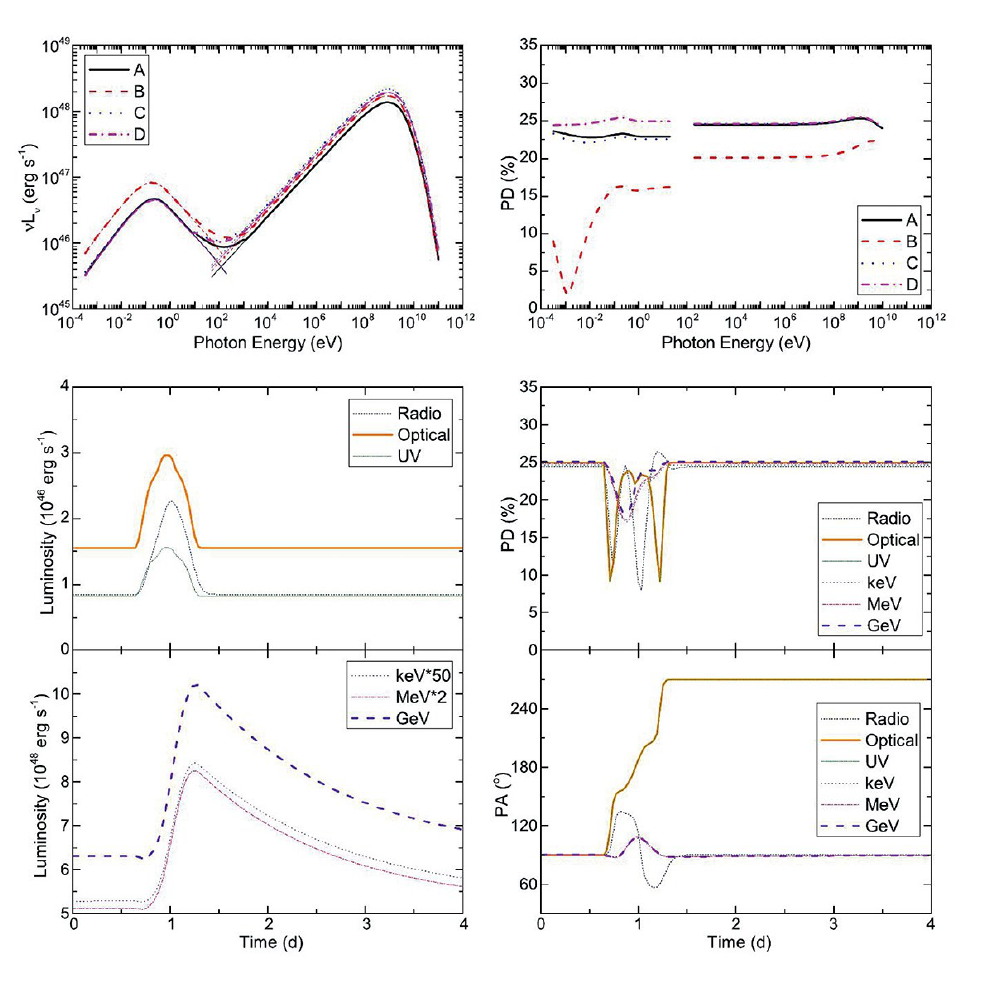
Figure 5. Radiation and polarization signatures from a proton-synchrotron-dominated lepto-hadronic shock-in-jet model, in a scenario where flaring activity is initiated by more efficient particle acceleration accompanied by a decrease of the magnetic field (magnetic energy dissipation), and where the light crossing time across the jet is shorter than the characteristic radiative cooling time of the highest-energy protons. Top left: Snap-shot SEDs for (A) the pre-flare equilibrium state, (B) a period shortly before the peak of the flare, (C) the peak of the flare, and (D) during the decay phase after the flare peak. Top right: Polarization Degree (PD) as a function of photon energy for the same epochs as the SEDs shown in the top-left panel. C enter and bottom left: Multi-wavelength light curves; center and bottom right: Time-dependent Polarization Degree (PD) and Polarization Angle (PA) at various photon energies. From